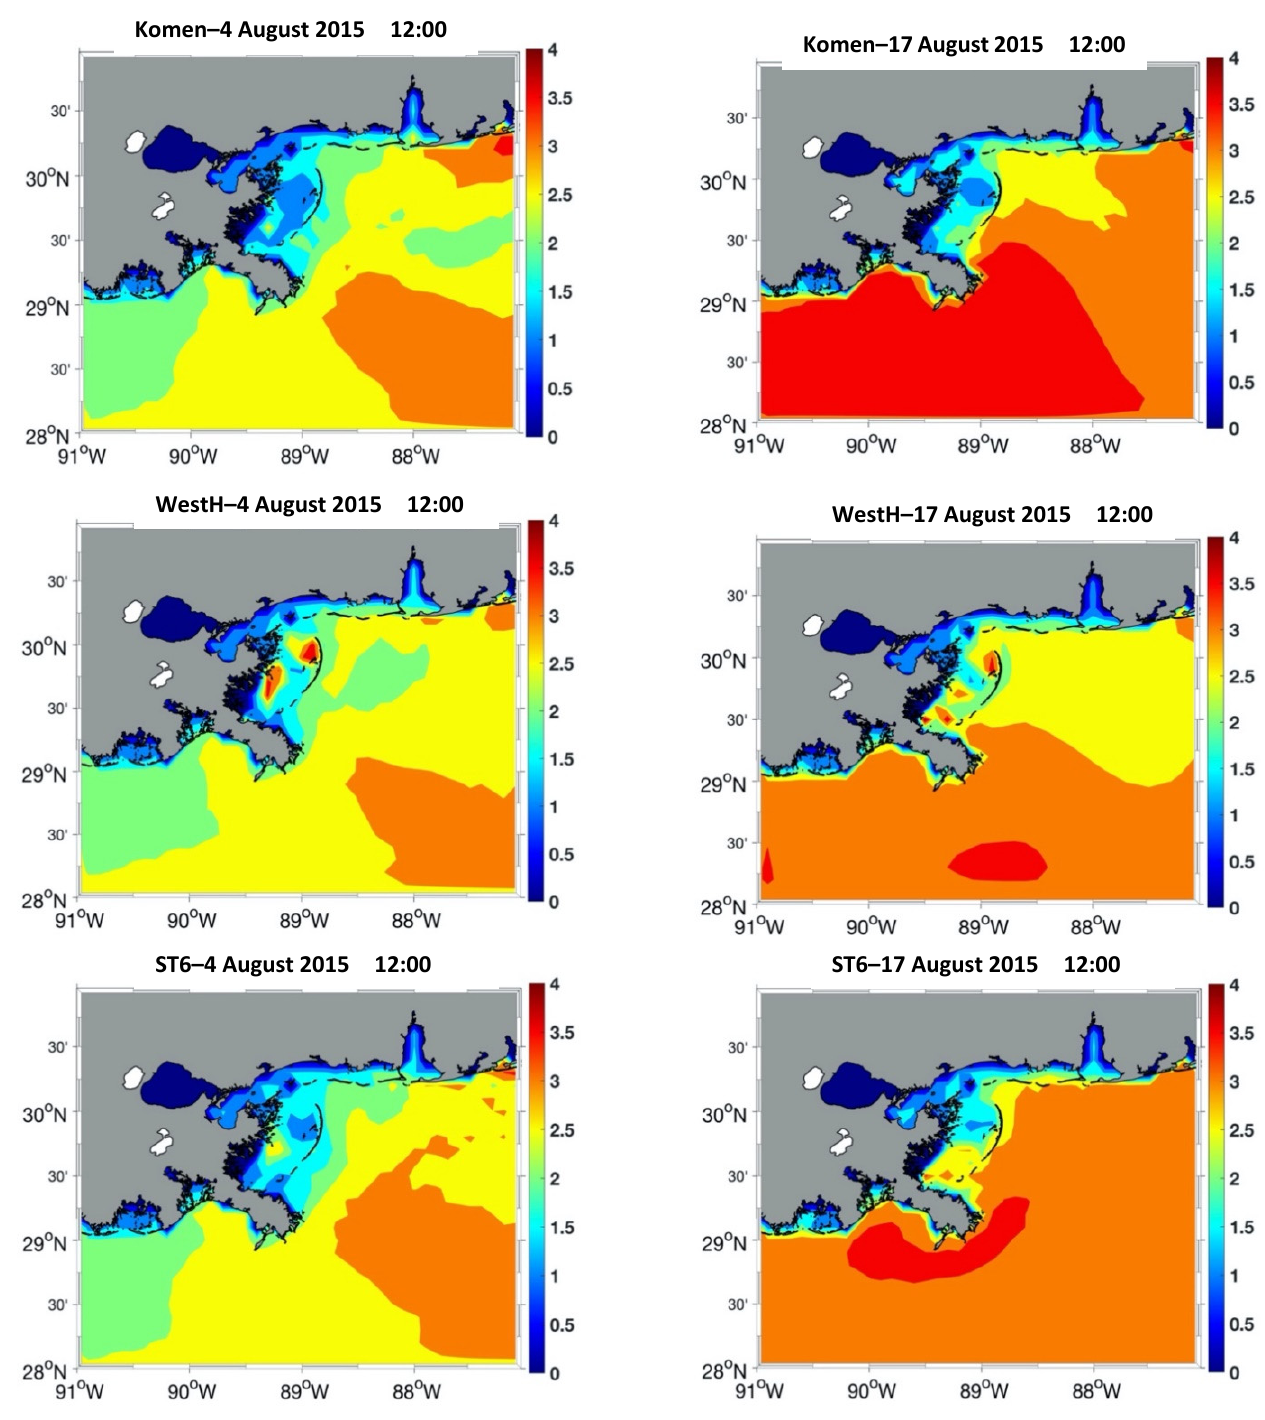
Figure 9. Mean wave period (s) at t 1 (4 August 2015; 12:00:00) and t 2 (17 August 2015) correspond to simulations using Komen, Westhuysen, and ST6 whitecapping formulations.